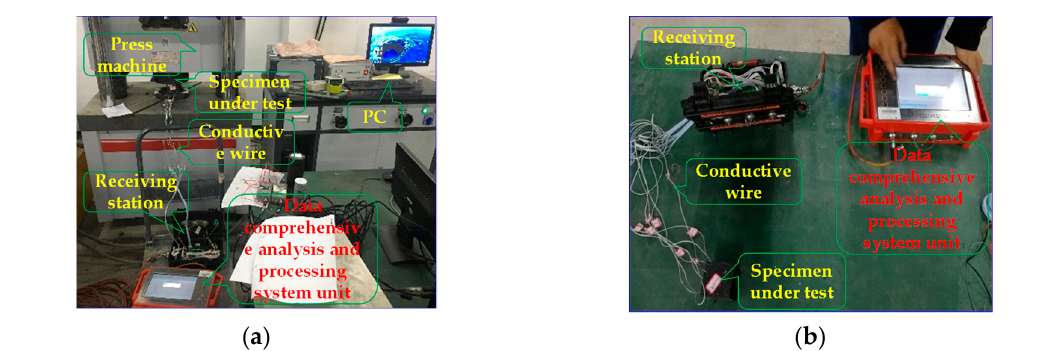
Figure 1. Specimen preparation flow chart.